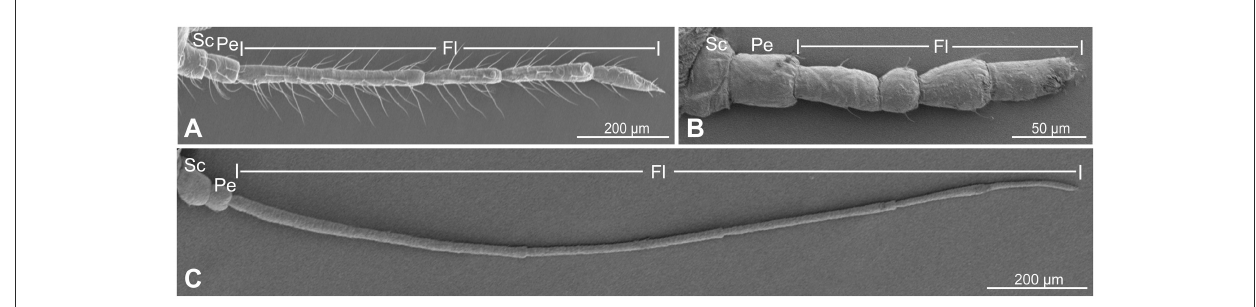
FIGURE1 Full views of the antenna in three aphid species. (A) Cinara cedri ; (B) Eriosoma lanigerum ; (C) T. trifolii . Sc, scape; Pe, pedicel; Fl, flagellum.